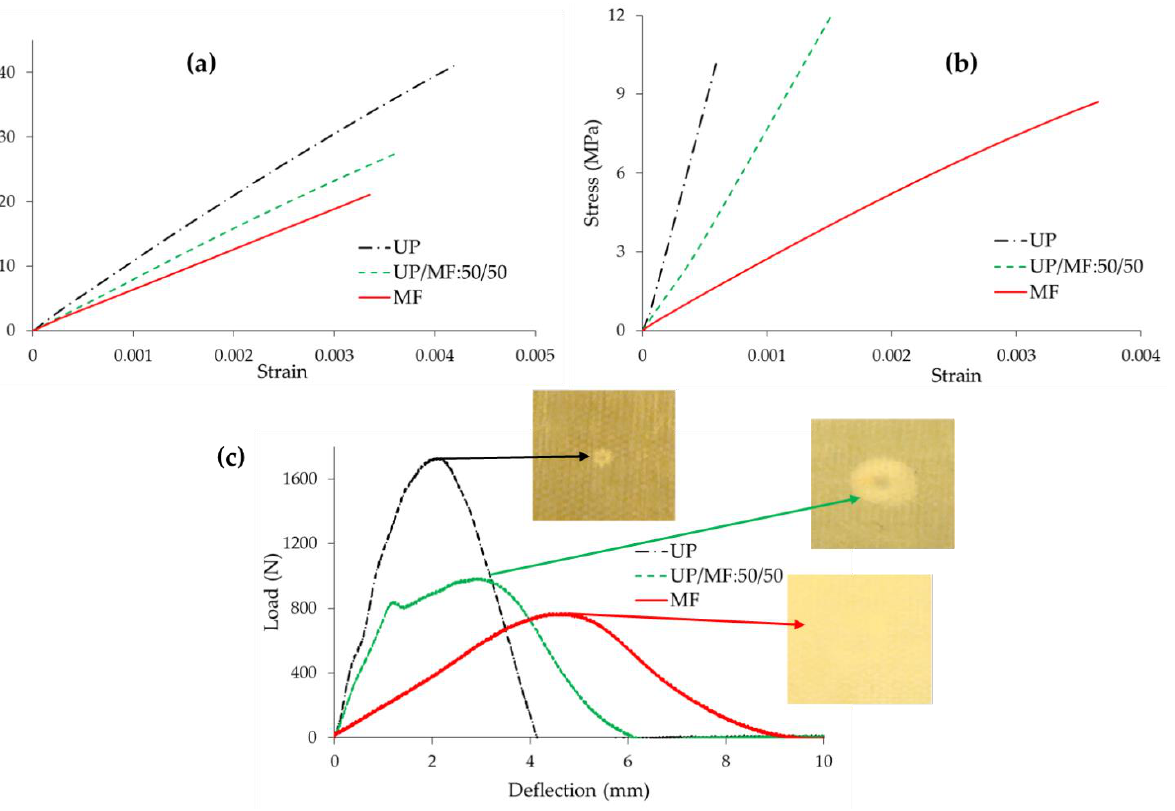
Figure 8. ( a , b ) Stress vs. strain curves under ( a ) tensile, ( b ) flexural; and ( c ) load vs. deflection curves under impact load of 1.02 kg and 100 mm drop height, with digital images after the impact test of GFRC samples of UP, UP/MF:50/50, and MF. Table 8. Mechanical properties of GFRCs of UP, MF, and their 50/50 blend.